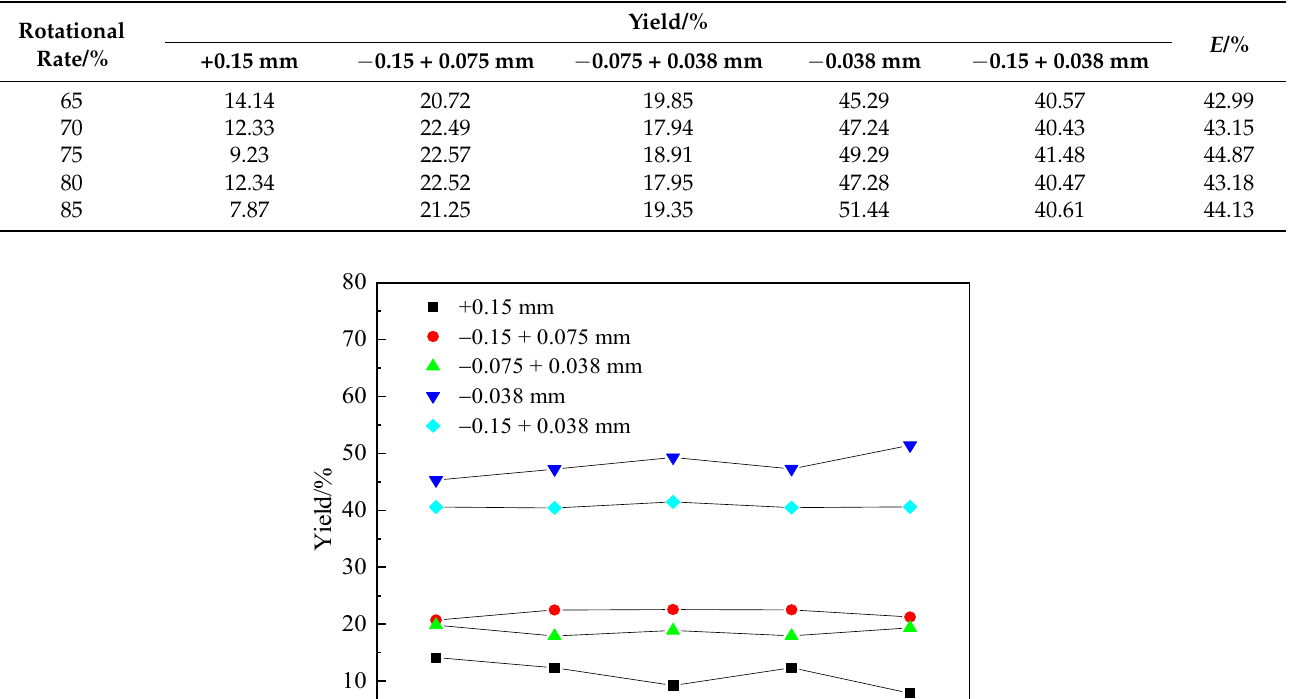
Table 7. Particle size composition of grinding product at different rotational rates.